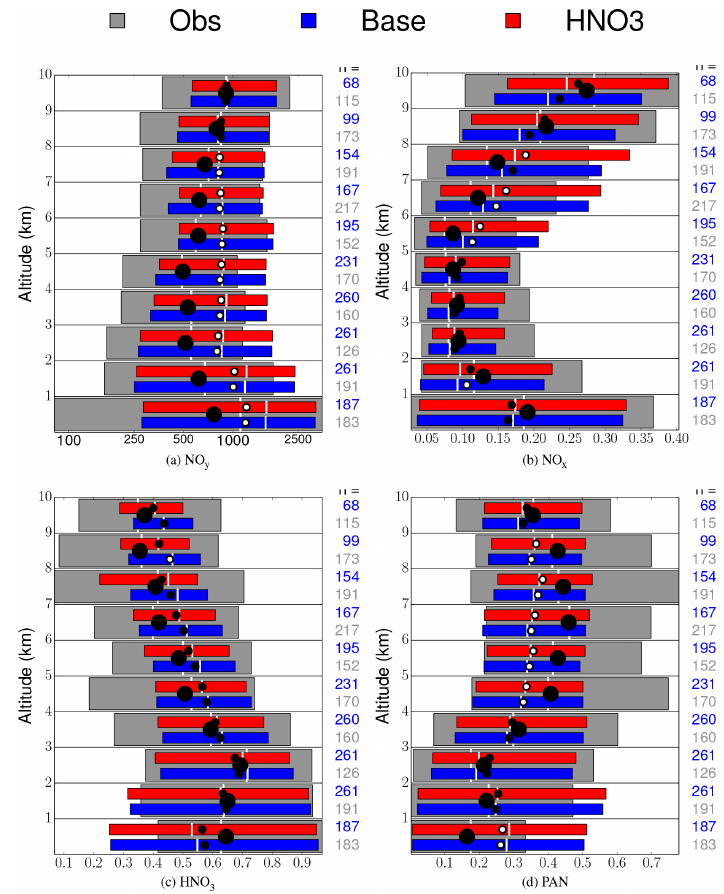
Figure 2. Model evaluation at ten 1km vertical bins. Each panel shows the 5th to 95th percentile range (box), median (white line), and mean (circle) for observations (grey), the base case (blue), and the HNO 3 case (red). When the mean circle for the predictions is filled in, the mean values between the observations and the predictions are not statistically different. The time period of these values matches the INTEX-A time period. The number of observations (black) and model points (blue) per 1km bin are detailed in the